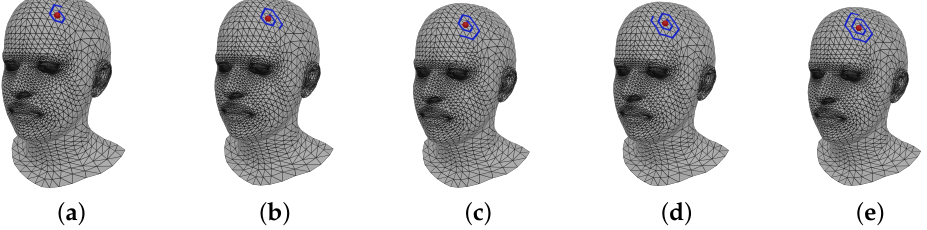
Figure 3. Visualization of spiral sequences with different user parameter. ( a ) l = 9; ( b ) l = 12; ( c ) l = 15; ( d ) l = 18; ( e ) l =